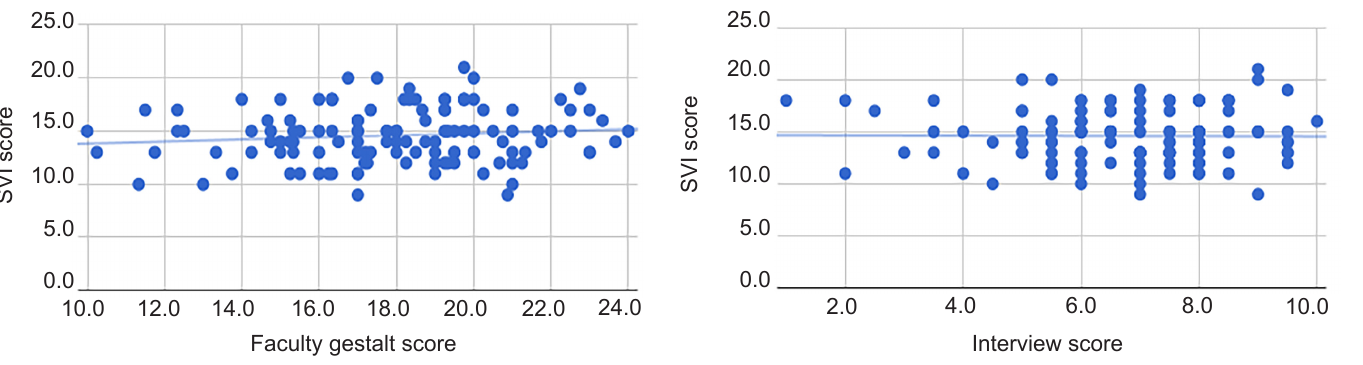
(123)=0.01, p=0.93), s